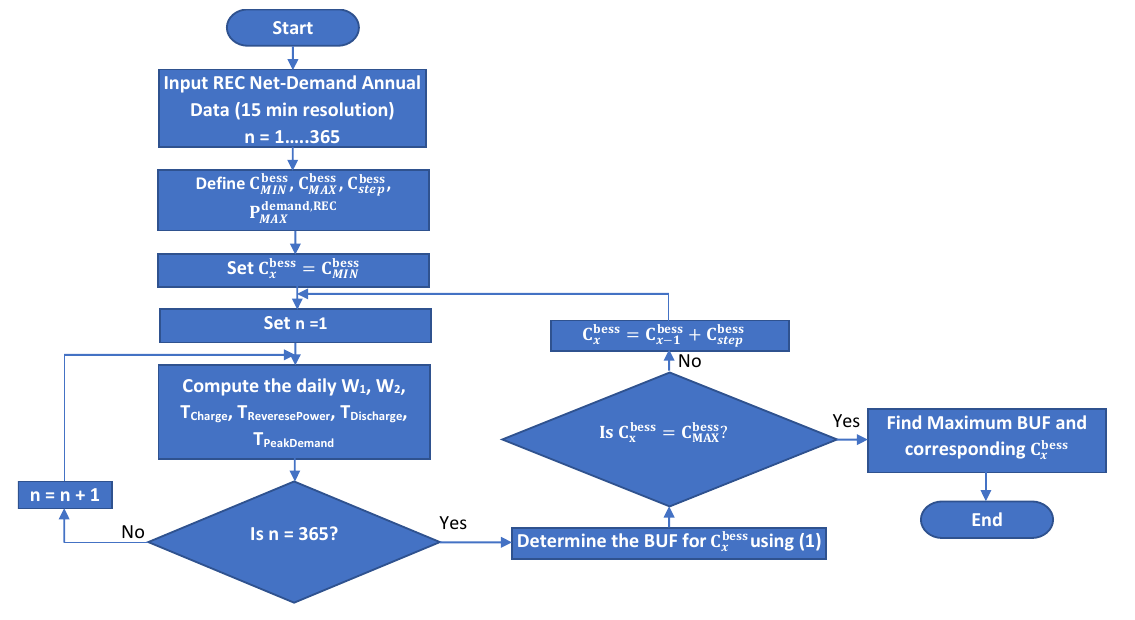
Figure 7. Flowchart of the BESS sizing procedure using the BUF Strategy (n = 1,…, 365 is the day number.